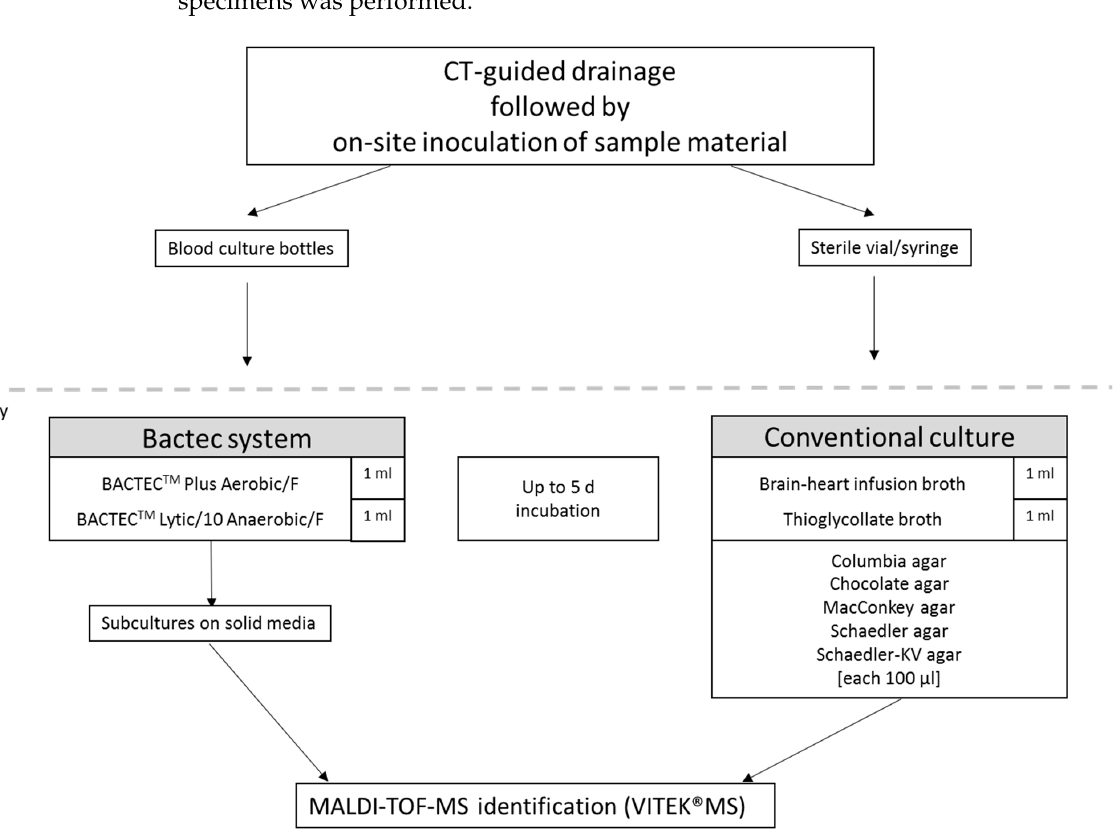
Figure 1. Specimens processing. Displayed are the specimen collection and processing modes. Volume information (in mL or µL) indicates the amount of specimen used for inoculation of the corresponding media.